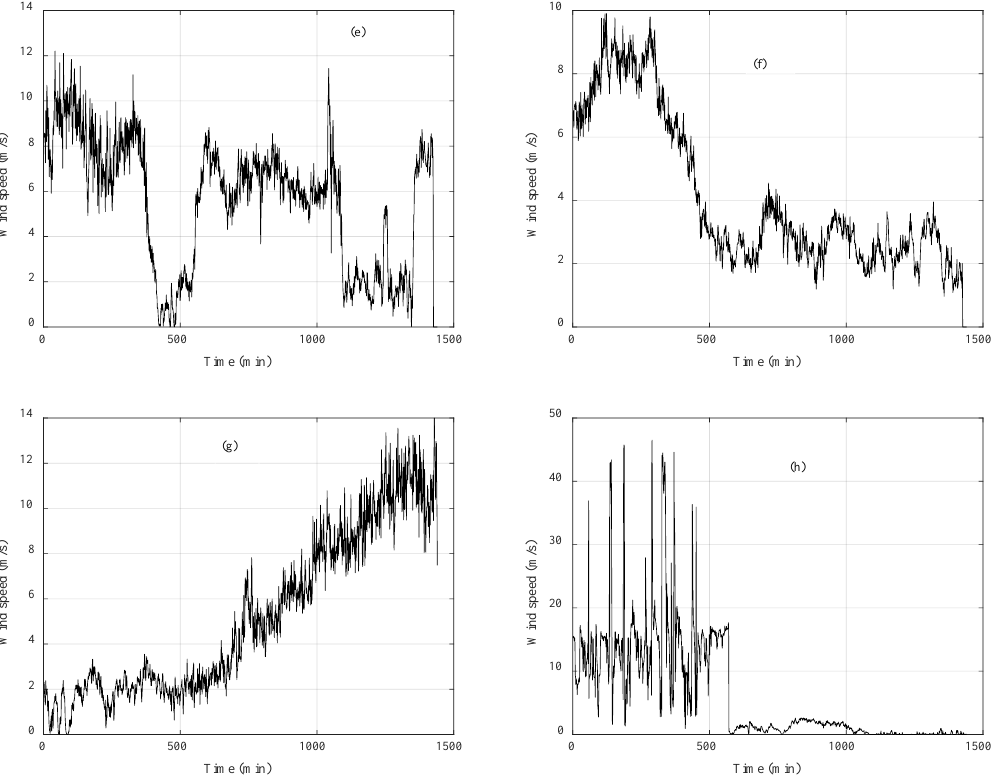
Figure 11. Wind speed profiles after the application of the UPGMC algorithm: ( a ) Profile#1; ( b ) Profile#2; ( c ) Profile#3; ( d ) Profile#4; ( e ) Profile#5; ( f ) Profile#6; ( g ) Profile#7; ( h ) Profile#8. Table 3. Number of days and day types per cluster. The clustering was held with the UPGMC algorithm.